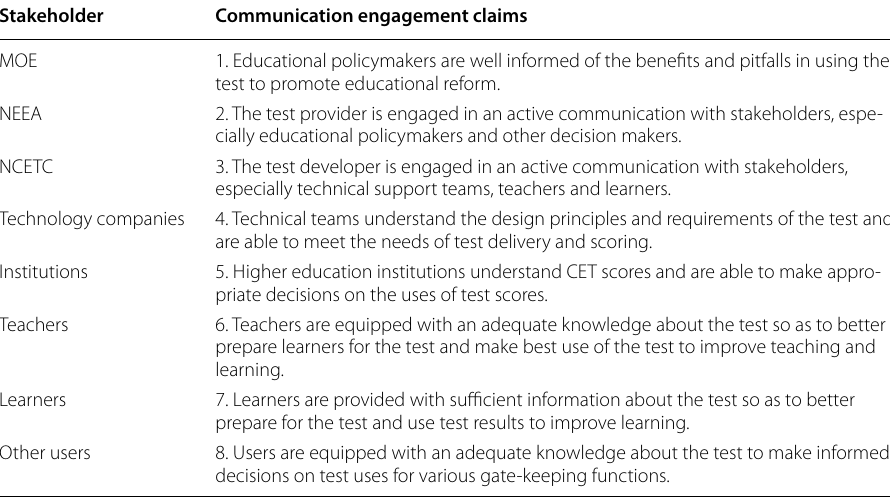
Table 2 Claims for the communication argument of CET consequences